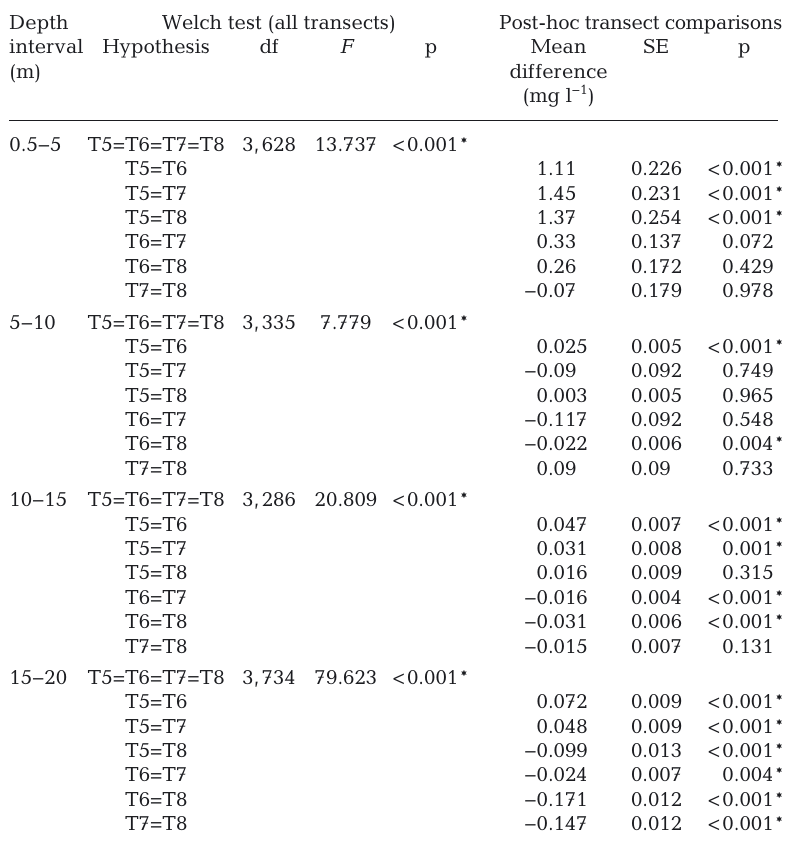
Table 2. Welch ANOVA and post-hoc test results of mean concentrations of total sus- pended particulate matter (mg l −1 ) between sampling transects at the Navy Island salmon farm on 1 December 2010. The location of each transect (T5 to T8) is shown in Fig. 3C and ANOVA comparisons are for the indicated transects and depth ranges. *Significant at α =